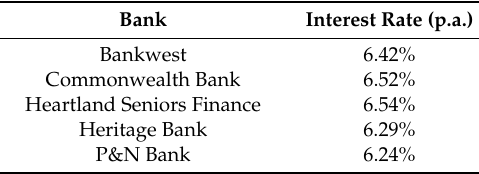
Table 3. Current reverse mortgage loan interest rates in Australia.